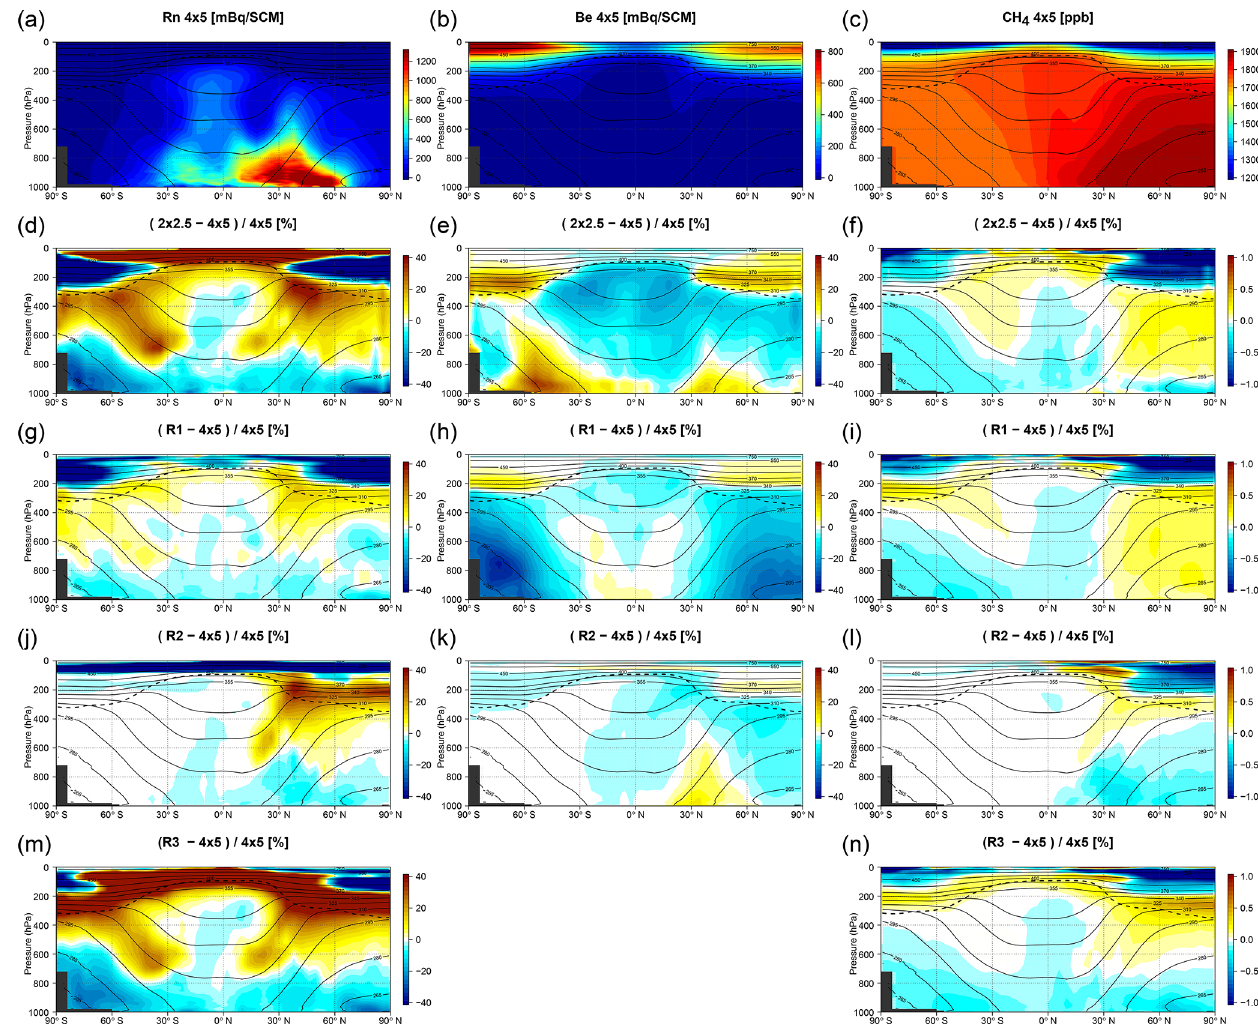
Figure 6. Evaluation of the zonal mean distribution of 222 Rn (left column), 7 Be (middle column), and CH 4 (right column) in March 2010 in GEOS-Chem. First row: the zonal mean tracer concentrations. Second row: the mean difference between the 2 ◦ × 2 . 5 ◦ and the 4 ◦ × 5 ◦ simulations. Third row: the mean difference between the R1 experiment and the 4 ◦ × 5 ◦ simulations. Fourth row: the mean difference between the R2 experiment and the 4 ◦ × 5 ◦ simulations. Fifth row: the mean difference between the R3 experiment and the 4 ◦ × 5 ◦ simulations. R1 is the 4 ◦ × 5 ◦ simulation driven with regridded 2 ◦ × 2 . 5 ◦ hAMFs, R2 is the 4 ◦ × 5 ◦ simulation with the hAMF GEOS-Chem nested grid domains for North America (NA), Europe (EU), and Asia (CH) replaced by regridded 0 . 5 ◦ × 0 . 67 ◦ hAMFs, and R3 is the 4 ◦ × 5 ◦ simulation driven with regridded 2 ◦ × 2 . 5 ◦ hAMFs and with an additional CH 4 eddy mass flux based on the 2 ◦ × 2 . 5 ◦